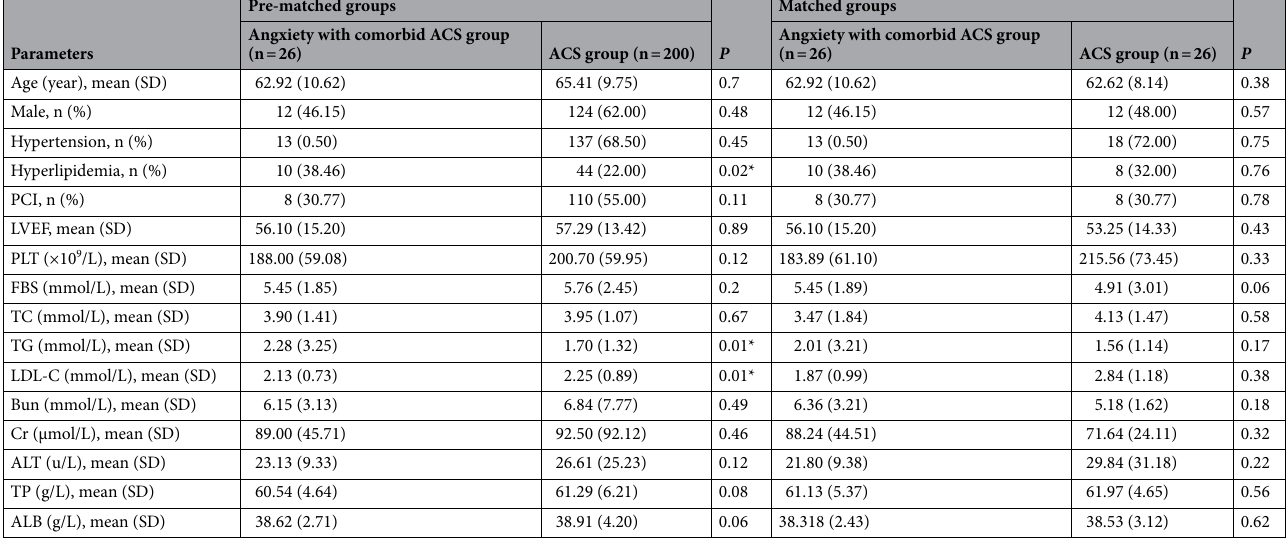
Table 1. Demographic information of the enrolled participants about angxiety comorbidity with ACS and ACS group before and after PSM. SD, standard deviation; PSM, propensity score matching; * p <